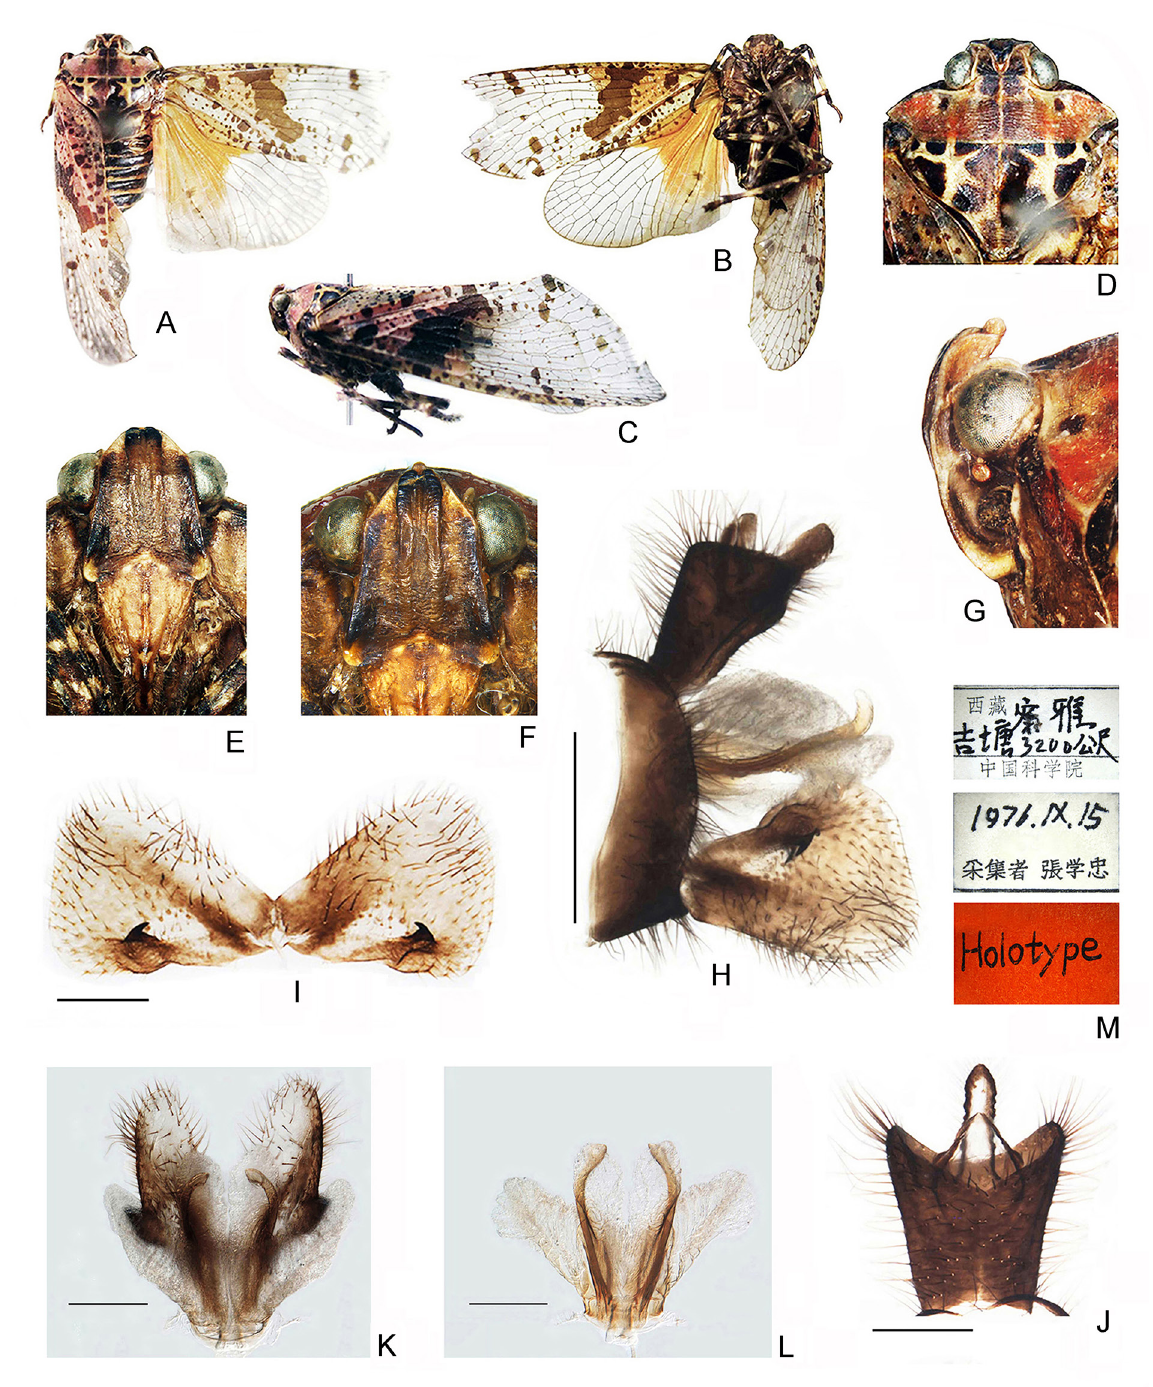
Fig. 1. Limois chagyabensis Chou & Lu, 1981. A – G . Holotype, adult female. A . Dorsal view. B . Ventral view. C . Left lateral view. D . Head and thorax, dorsal view. E – F . Face. G . Head and thorax, left lateral view (showing reflexed protuberance of the vertex). H – L . NWAFU HO088523, male genitalia. H . Left lateral view. I . Gonostylus, ventral view. J . Anal tube, dorsal view. K . Aedeagus and gonostylus, dorsal view. L . Aedeagus, ventral view. M . Labels of the holotype. Scale bars: H = 1.0 mm; I–L = 0.5